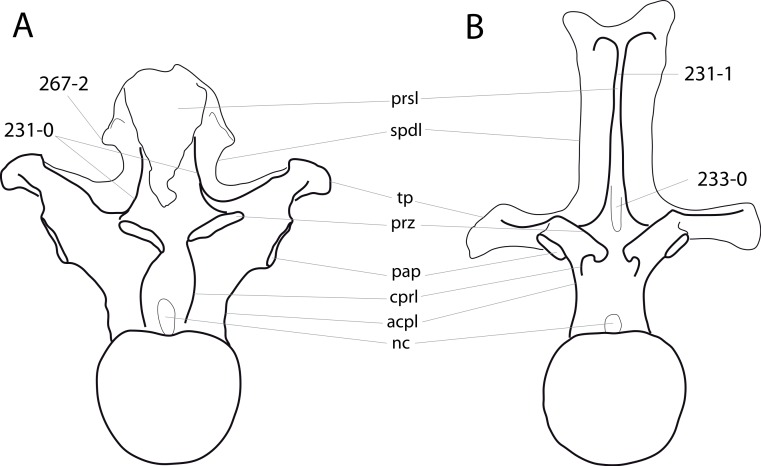
Dorsal vertebra 8 of neosauropods.Dorsal vertebra 8 of Camarasaurus supremus AMNH 5760 (A; traced from Osborn & Mook, 1921) and Apatosaurus louisae CM 3018 (B; traced from Gilmore, 1936) in anterior view. Note the separated (A; C231-0) or dorsally united spinoprezygapophyseal laminae (B; C231-1), the fossa between them (B; C233-0), and the triangular processes of the neural spine, that project further than the zygapophyses (A; C267-2). Abb.: acpl, anterior centroparapophyseal lamina; cprl, centroprezygapophyseal lamina; nc, neural canal; pap, parapophysis; prsl, prespinal lamina; prz, prezygapophysis; spdl, spinodiapophyseal lamina; tp, transverse process. Scaled to same anterior condyle height.